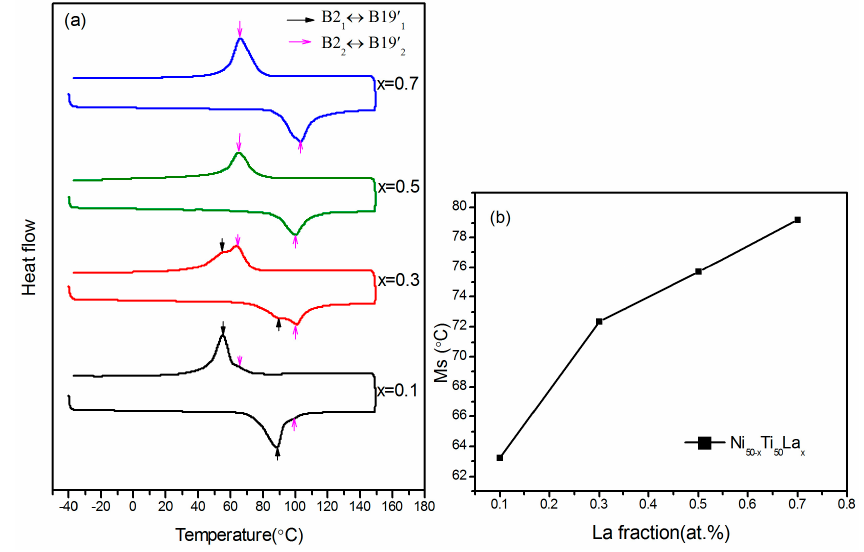
Figure 5. DSC results of Ni 50 − x Ti 50 La x alloys: ( a ) DSC curves; ( b ) Ms vs. La content.